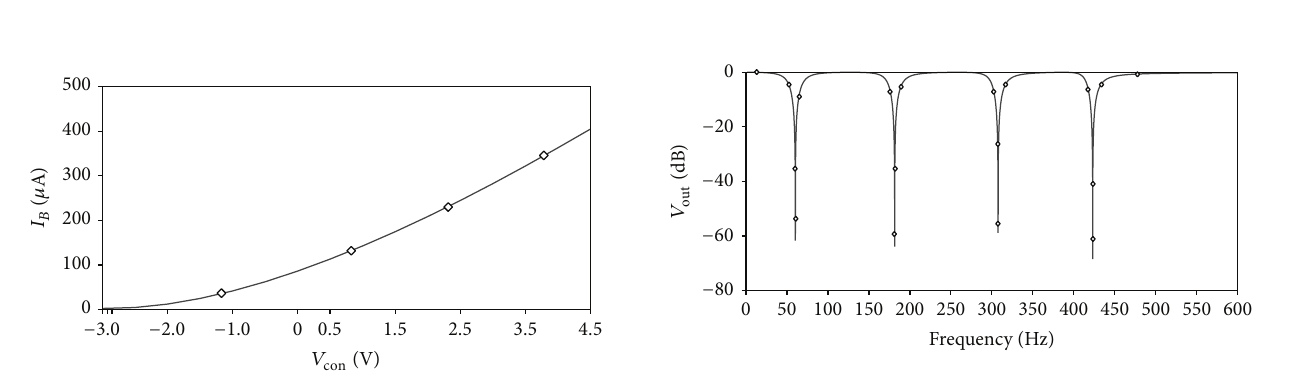
Figure 6: Generalized OTA-C comb filter.